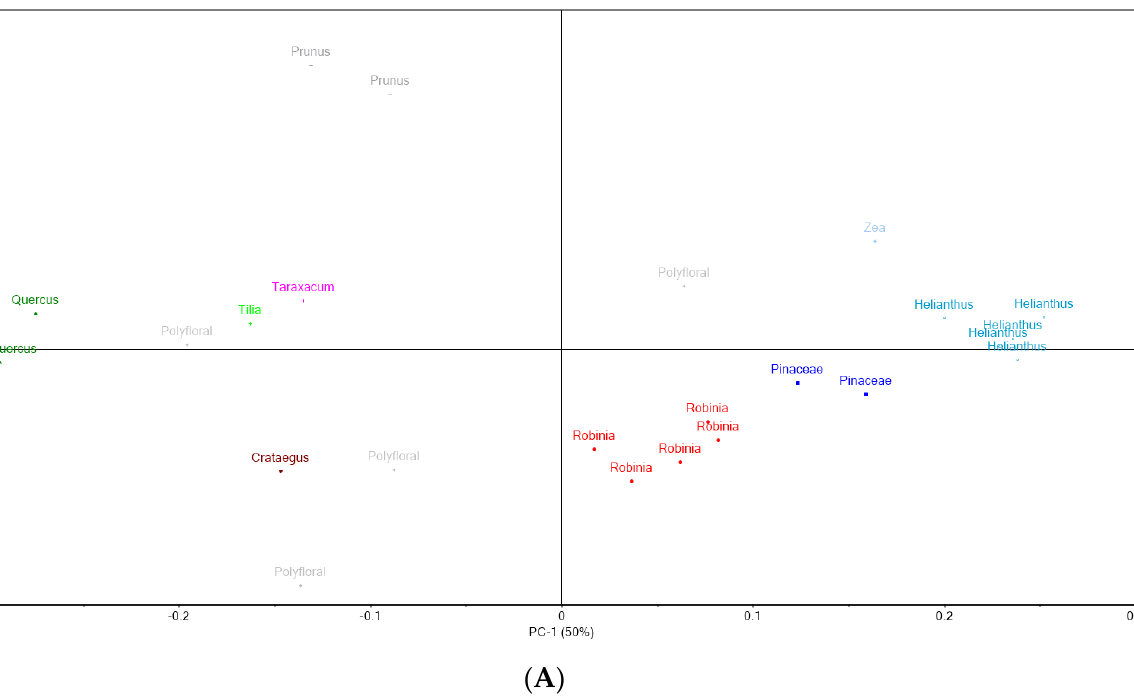
( B ) Figure 2. Principal component analysis scores ( A ) and loadings ( B ) of the bee pollen based on their physicochemical, organic acids, sugars, TPC, TFC, phenolics compounds, amino acids, fatty acids: a — scores, b — loadings, Fa-free acidity, Mo — moisture content, Fa-lipids, p-protein content, Fru- fructose, Glu-glucose, Suc-sucrose, Tur-turanose, Mal-maltose, Tre-trehalose, Mel-melesitose, Raf- raffinose, GluA-gluconic acid, LacA-lactic acid, AceA-acetic acid, ProA- propionic acid, TPC-total phenolic content, TFC-total flavone content, p-a — protocatecuic acid, 4-h-a — p-hydroxibenzoic acid, C-a — chlorogenic acid, p-c-A — p-coumaric acid, R-a — rosmarinic acid, V-A vanillic acid, Ala-ala- nine, Sar-Sarcosine, Gly-glicine, Val-valine, Leu-leucine, Iso — isoleucine, Thr-threonine, Ser-Serine,